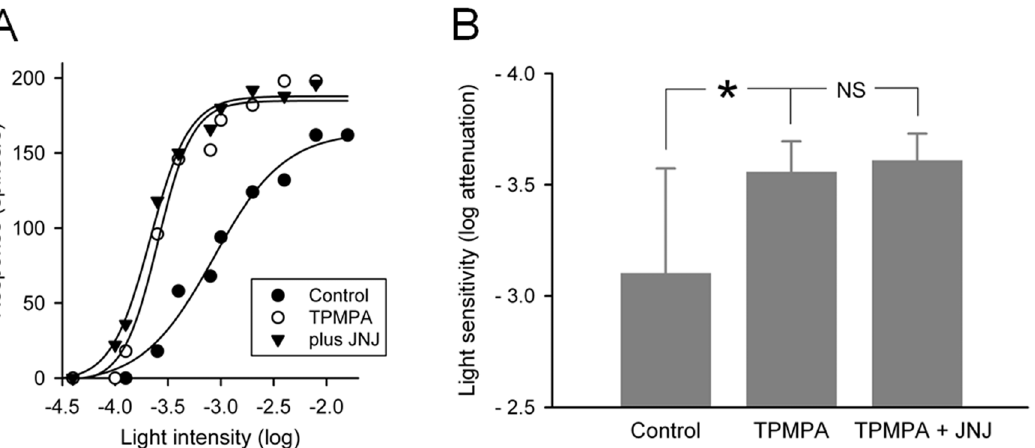
Figure 4. Occlusion of JNJ16259685 effect on light sensitivity of ON-center P23H rat RGCs by a GABA C receptor antagonist. ( A ) Intensity-response curves from one RGC, taken before drug application, during application of TPMPA (100 m M), and after addition of JNJ16259685 (0.5 m M) to the bathing solution. The abscissa is labeled as log-unit attenuation in stimulus intensity from the maximum (8.5 6 10 17 photons/cm 2 /s). ( B ) Summary of experimental results. Application of TPMPA (100 m M) causes a significant (* P , 0.05) increase in light sensitivity compared to control. Addition of JNJ16259685 (0.5 m M) to the TPMPA-containing bathing solution had no statistically significant effect. Data are expressed as the mean and standard deviation of the mean (n=6).